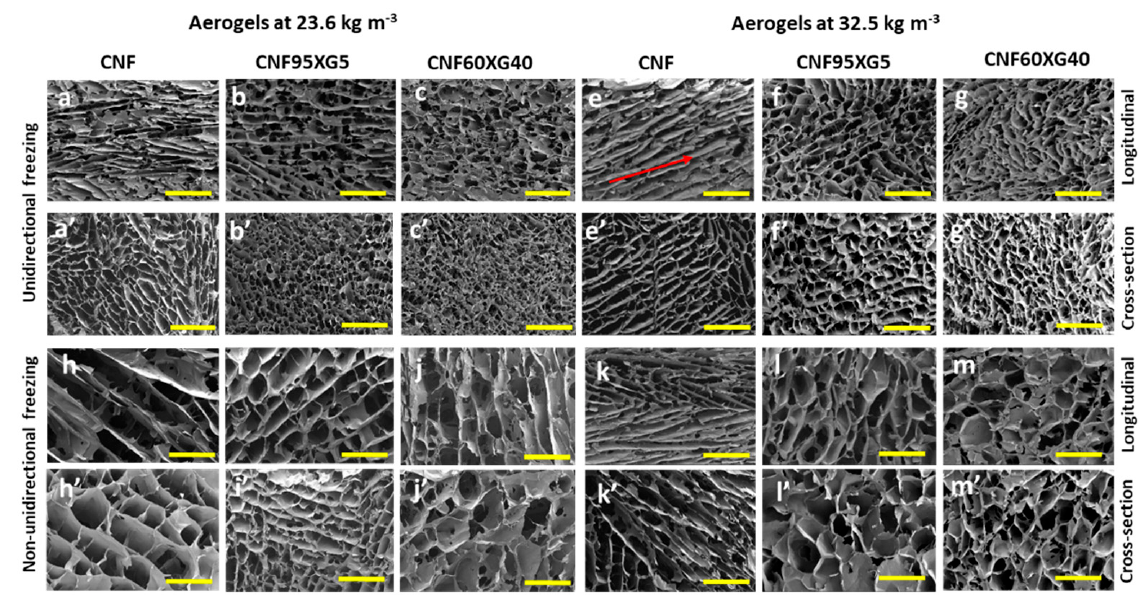
Figure 2. SEM images of the aerogels at 23.6 and 32.5 kg m − 3 with the three compositions CNF100, CNF95XG5, CNF60XG40 prepared by unidirectional ( a – g ; a’ – g’ ) and non-directional ( h – m ; h’ – m’ ) freezing processes. SEM images from longitudinal ( a – g ; h – m ) and cross-section ( a’ – g’ ; h’ – m’ ) views. Yellow scale bars are of 500 µm.